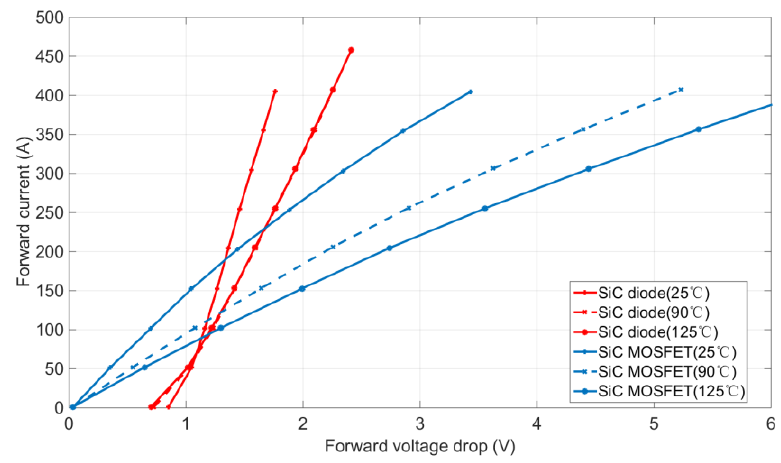
Figure 7. V–I characteristics of SiC MOSFET and antiparallel SiC diode at different temperatures.